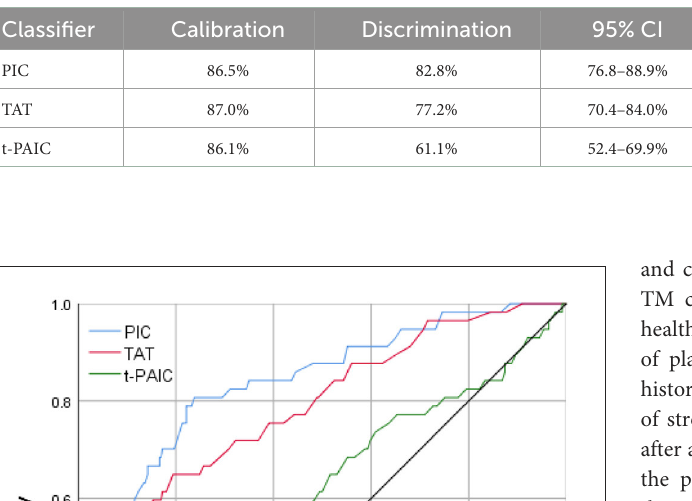
TABLE 3 Performance analysis of three markers for diagnosing MCI.